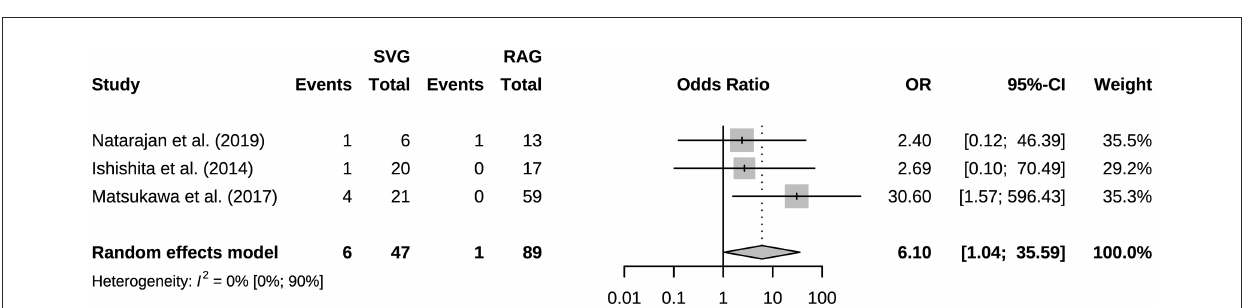
FIGURE5 Forest plot showing occlusion rate of saphenous vein graft was higher than radial artery